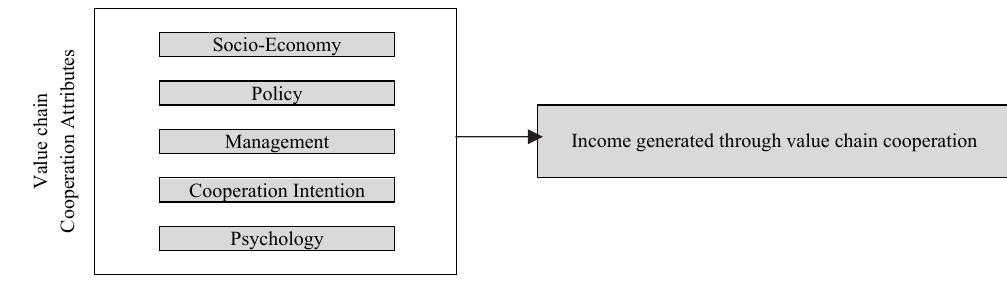
Fig. 1. Theoretical